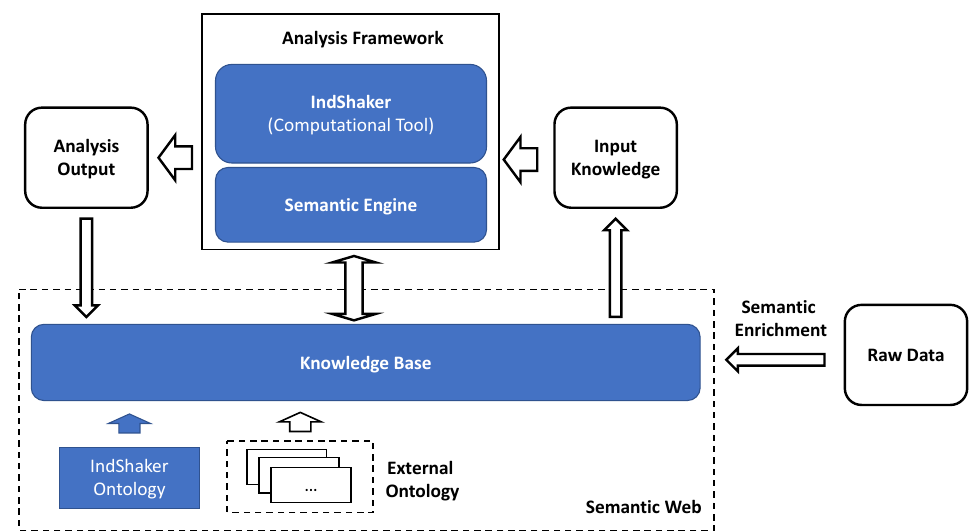
Figure 1. Reference